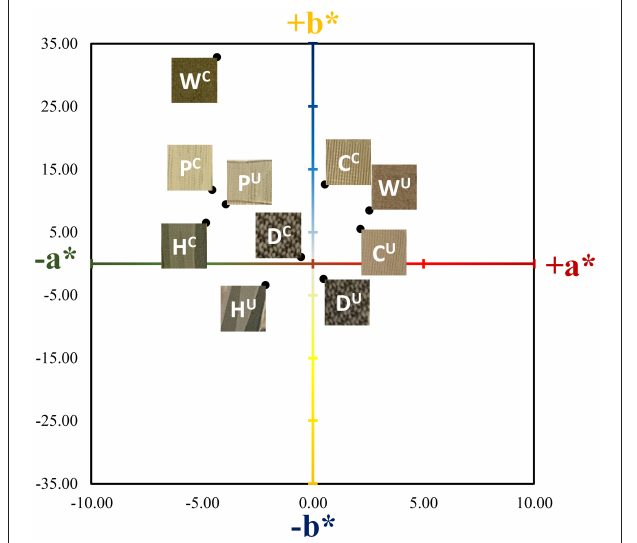
FIGURE 3 | Corresponding coordinate positions of the Vescom materials in CIELab color space for a* and b*. The L* values (white/black) were not plotted for simplicity. The superscripts U and C denote uncoated and coated (SbQ-PVA/ZnTMPyP 4 + ) materials, respectively. Labels are as follows: C, Capri; D, Deans; H, Husk; P, PRU-86364; W, Wolin.